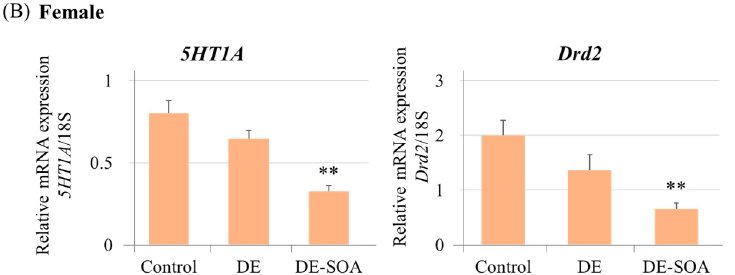
Figure 6. Messenger RNA expression levels of neurotransmitters in the hippocampus. Serotonin receptor ( 5HT1A ) and dopamine receptor ( Drd2 ) in the hippocampus of 10-week-old ( A ) male and ( B ) female rats of the control and the DE- or DE-SOA-exposed groups. ( n = 10, ** p < 0.01, * p < 0.05 vs. control).